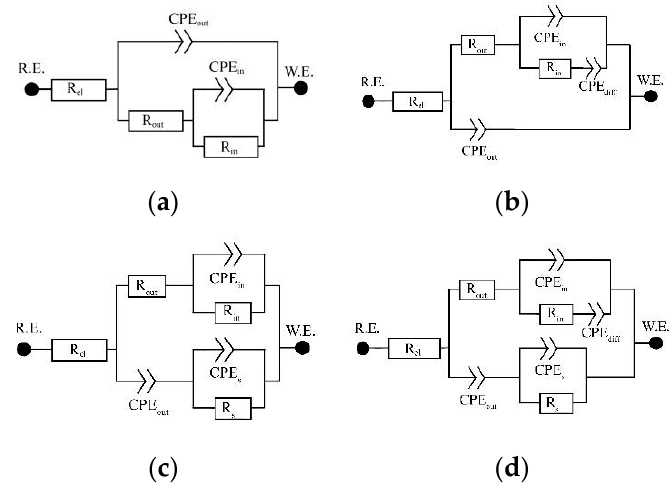
Figure 5. Equivalent circuits used for impedance spectra evaluation: (a) equivalent circuit for porous surface, (b) equivalent circuit for porous surface with diffusion element, (c) equivalent circuit for porous surface with surface inhomogeneity, (d) equivalent circuit for porous surface with surface inhomogeneity and diffusion. R = resistance, CPE = constant phase element.